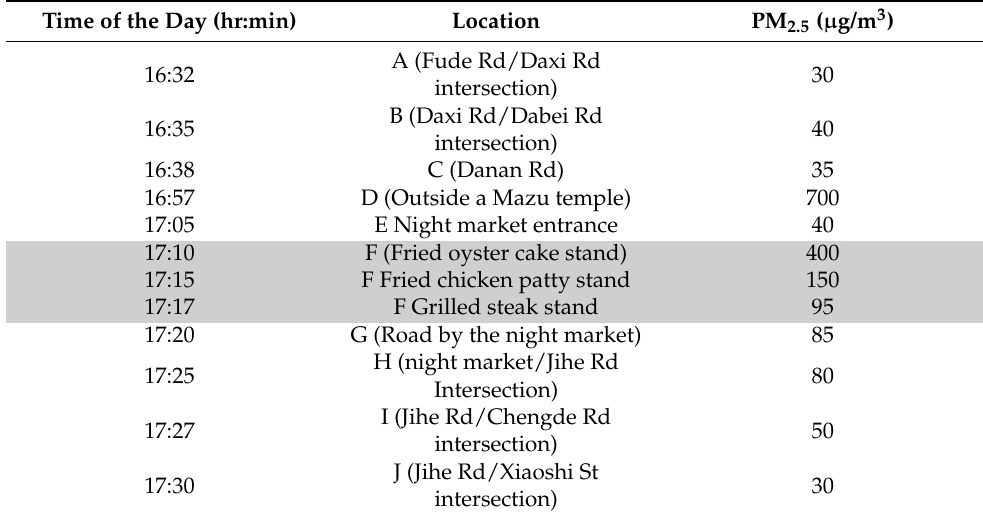
Table 3. PM 2.5 concentrations during a walk across a business